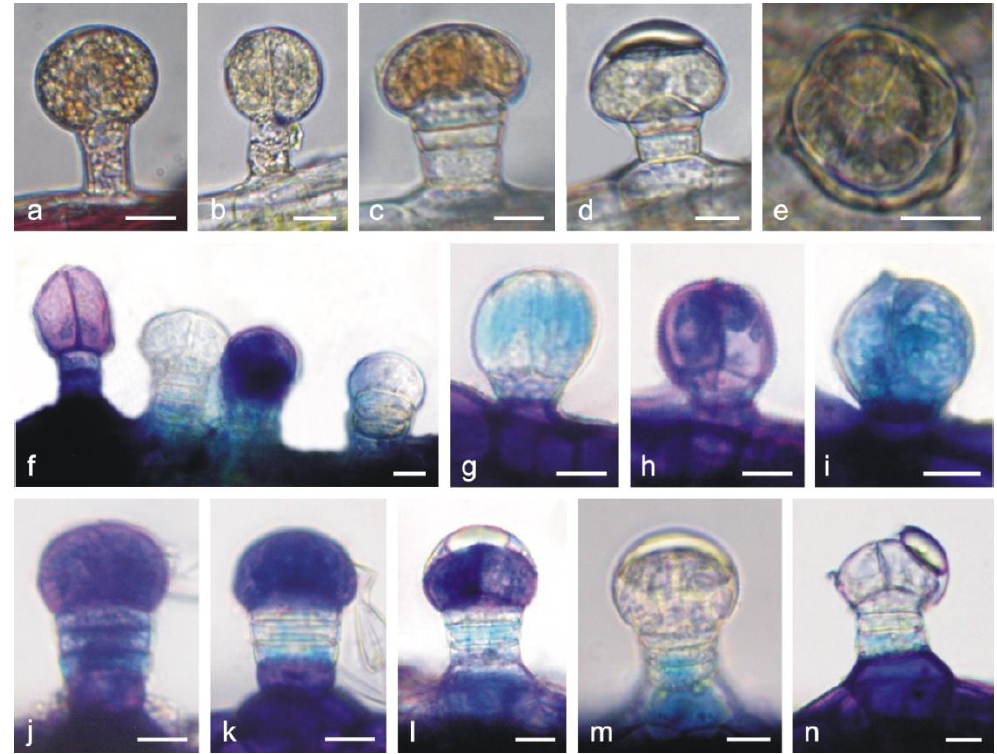
Figure 4. Glandular trichomes present on the L. album subsp. album calyx in LM. ( a – e ) Trichomes from non-stained control preparations. ( f – n ) Trichomes stained with Toluidine blue O. ( a ) Capitate trichome with 1-celled head. ( b ) Capitate trichome with 2-celled head. ( c – e ) Peltate trichomes at various stages of development. ( f – i ) Differently stained (blue and green) capitate trichomes after Toluidine blue O treatment indicating various contents of phenolic compounds. ( j – n ) Peltate trichomes with differently stained head cells at different stages of development after Toluidine blue O treatment. In the older trichomes, the secretion is visible in the subcuticular space of the head ( l , m ) or on its surface with a ruptured cuticle ( n ). Scale bars: 10 µm ( a – n ).